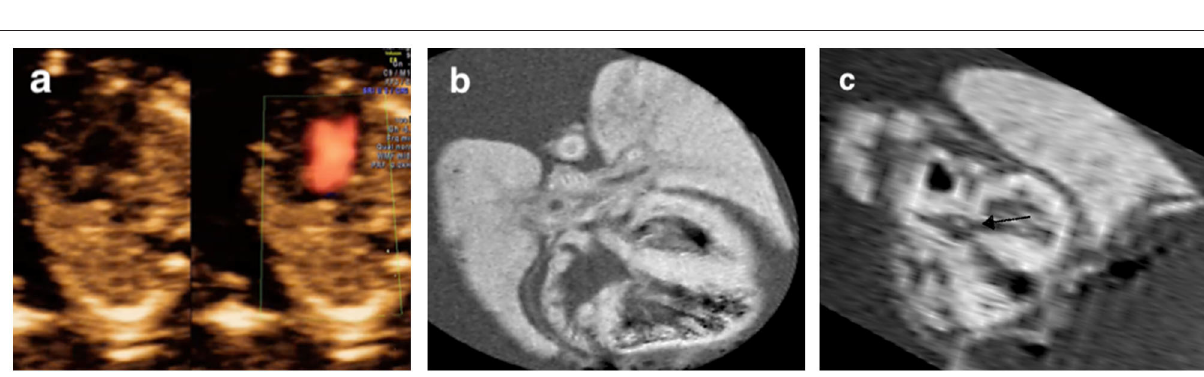
FIGURE 5 | Discordant findings of postmortem MRI and autopsy compared with prenatal ultrasound. A fetus (Case 17 in Table 2 ) was detected as transposition of the great arteries (a) and was terminated at 17 + 6 weeks of gestation for Trisomy 18. The postmortem MRI showed both aortic artery and pulmonary artery arose entirely from the right ventricle with the aorta to the right and anterior to the pulmonary artery. (b,c) The autopsy confirmed the diagnosis of double-outlet right ventricle (d,e) .